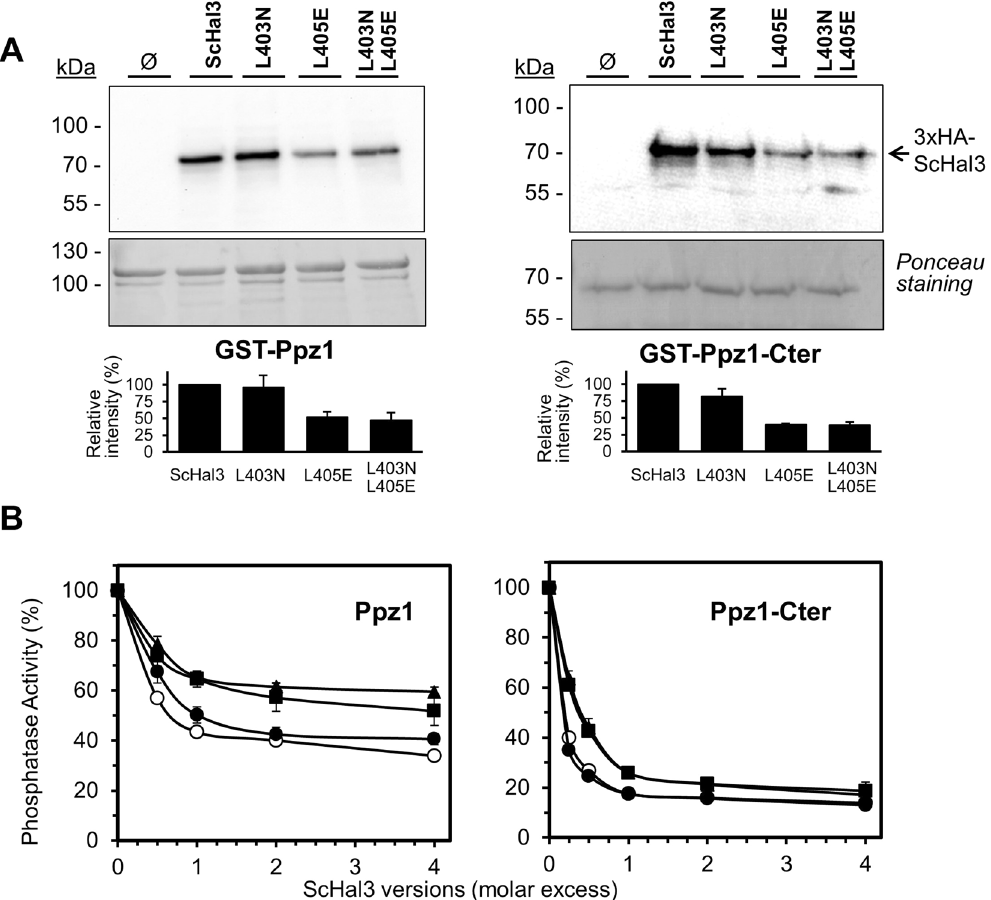
Figure 5. Ppz1 interaction and inhibitory capacity of ScHal3 variants. ( A ) Equal amounts of the indicated versions of the GST-tagged phosphatases were immobilized on glutathione beads and used as an affinity system to recover HA-tagged ScHal3 versions expressed from the pWS93 plasmid in IM021 ( ppz1 hal3 ) cells. Beads were washed and processed for SDS-PAGE (10% gels) and immunoblotting was carried out using anti-HA antibodies as described in Methods. Ponceau staining of the membranes reveals the relative amounts of GST-Ppz1 or GST-Ppz1-Cter. The histograms represent the relative interaction ability of the mutated versions, quantified from 3 independent experiments (mean ± SD). ( B ) Recombinant Ppz1 or its C-terminal catalytic moiety (10 pmols) were incubated with increasing amounts of recombinant native ScHal3 ( ○ ) or its variants ( ● , L403N; ▲ , L403N; ■ , L403N L405E). Data are represented as percentage of the activity of the enzyme preparations in the absence of inhibitors and correspond to the mean ± SEM from 4 to 8 independent determinations using at least two different preparations of each